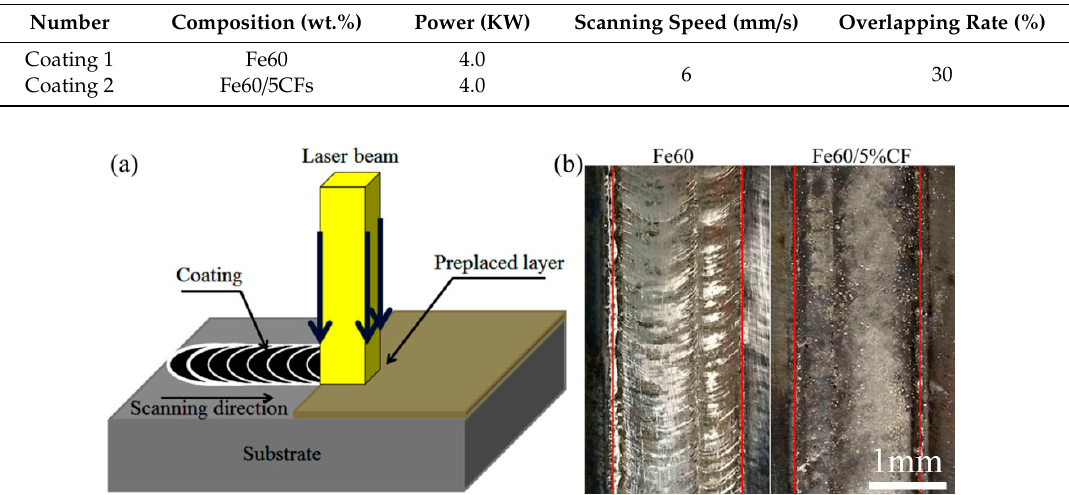
Figure 2. ( a ) The schematic diagram of the laser cladding process; ( b ) the surface morphologies of Coating 1 and Coating 2.